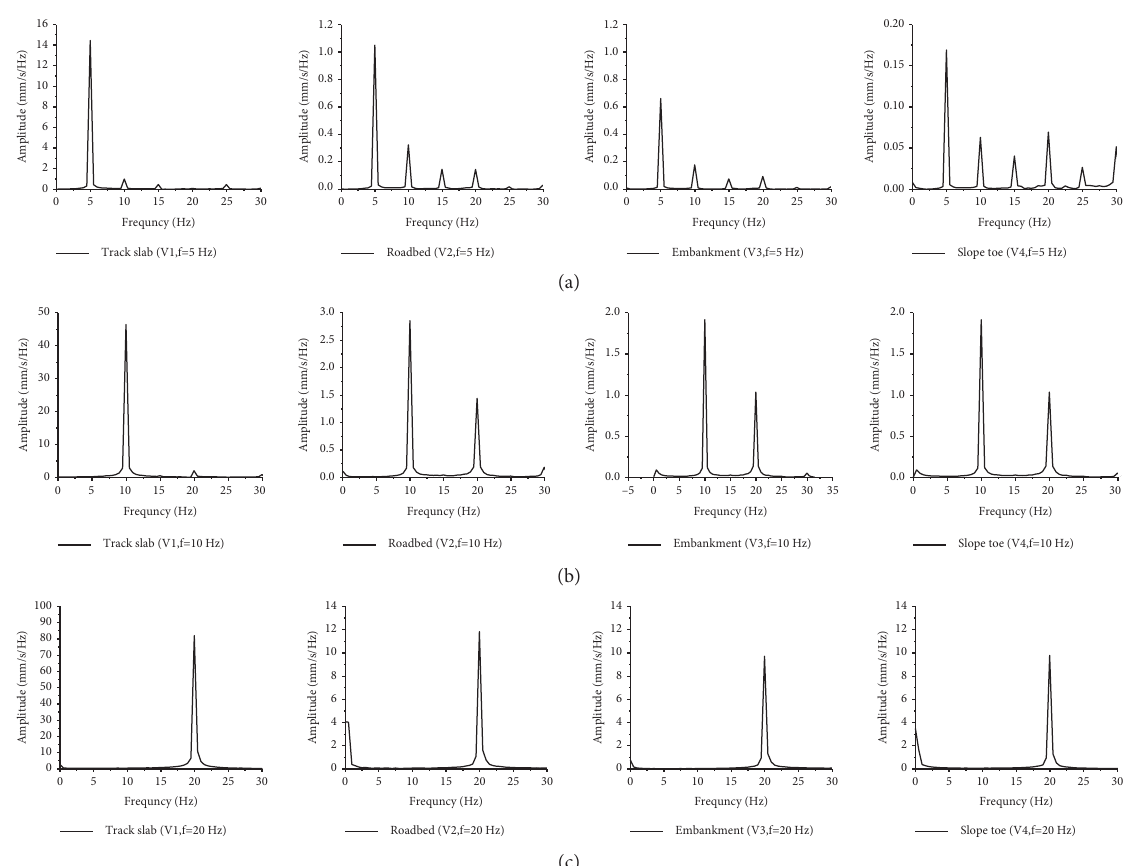
Figure 8: Frequency spectrum curves of vibration velocity at track slab, roadbed, embankment. (a) f � 5Hz. (b) f � 10Hz. (c) f � 20Hz.